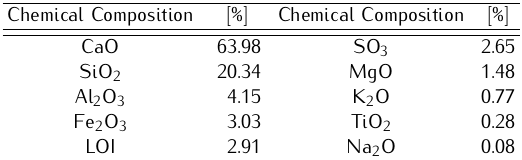
Table 1. Chemical composition of Goliath General Purpose cement.